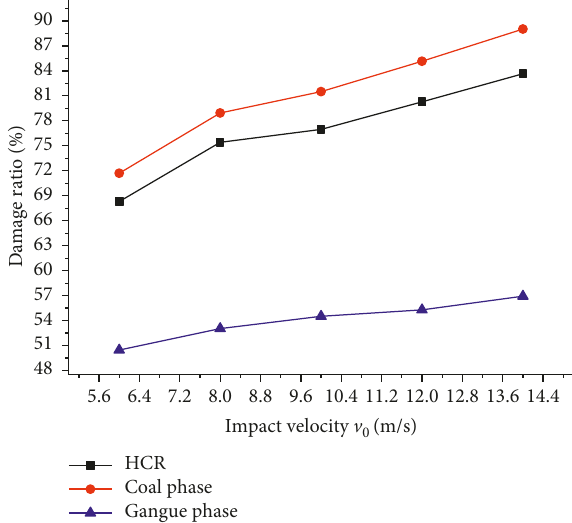
Figure 17: Variations of damage ratios of the HCR, coal phase, and gangue phase in the positive y -load mode under different impact velocities.